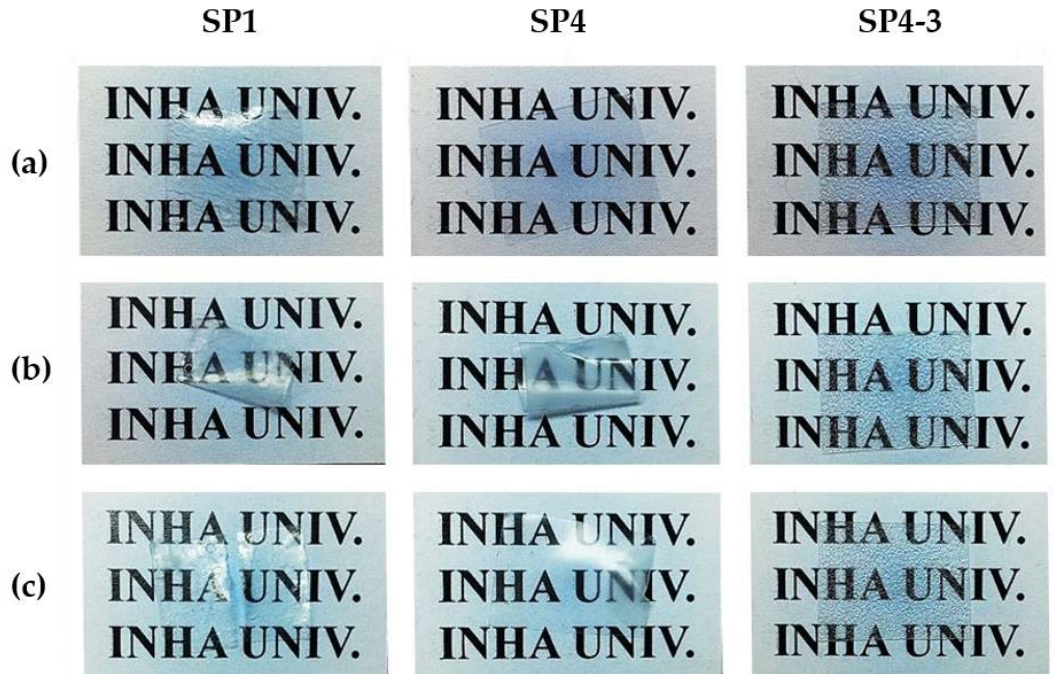
Figure 6. Photographs of ( a ) As-prepared solid polymer electrolyte samples, ( b ) Solid polymer samples which were heat-treated at 80 °C for 6 h and then folded, and ( c ) Solid polymer samples which were heat-treated at 80 °C for 6 h and then stretched.